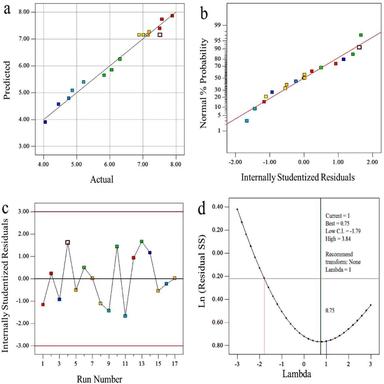
Comparative diagnosis of the adequacy of the fitting model for essential oil yield. Predicted and actual values (a), normal% probability (b), internationally studied residuals (c) and Box-Box Plot for Power Transforms (d).